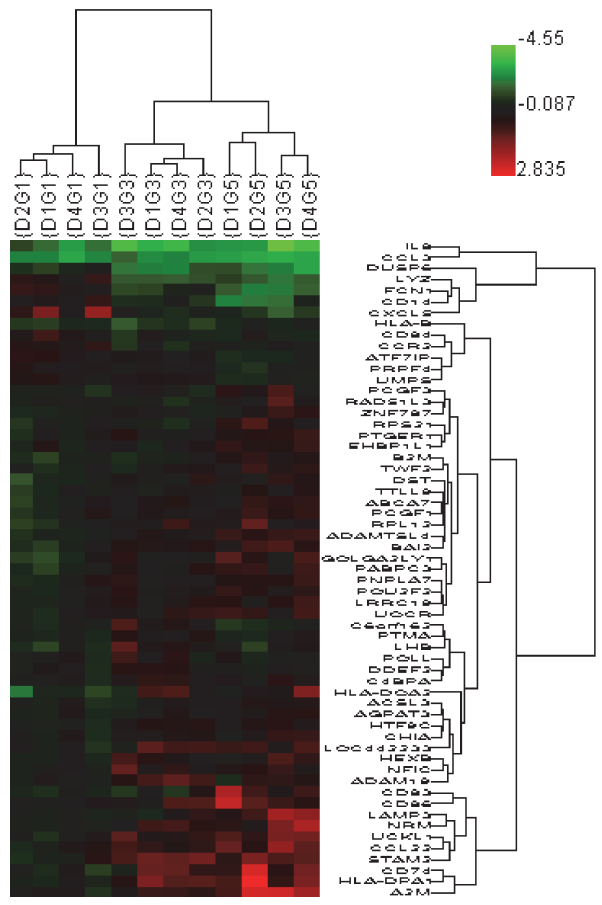
Figure 2. Supervised Hierarchical Clustering Analysis (HCA) presenting a set of significant 59 genes that distinguished three differentiation stages of DCs: piDC (G1), iDC (G3) and mDC (G5). Microarray data of piDC, iDC and mDC from donor D1–D4 were analyzed by ANOVA. Significant genes among the three stages were selected using the criteria set at p-value , 0.05 and fold change $ 1.5. Genes with F-ratio . 4.7 were presented. Color indicator shows log2 value of the intensity of sample against